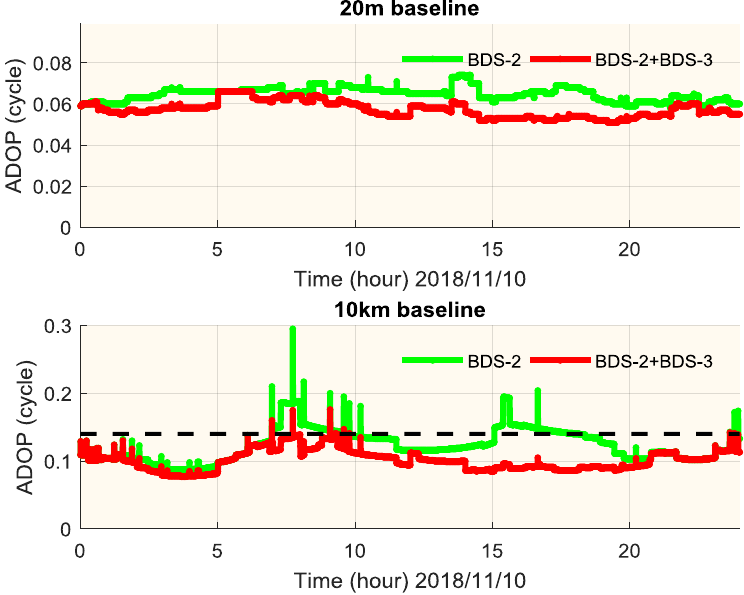
Figure 14. Epoch-by-epoch ADOP of BDS-2-only and BDS-2 + BDS-3 at 20 m baseline ( upper ) and 10 km baseline ( lower ). The black dashed line refers to an ADOP value of 0.14 cycle.